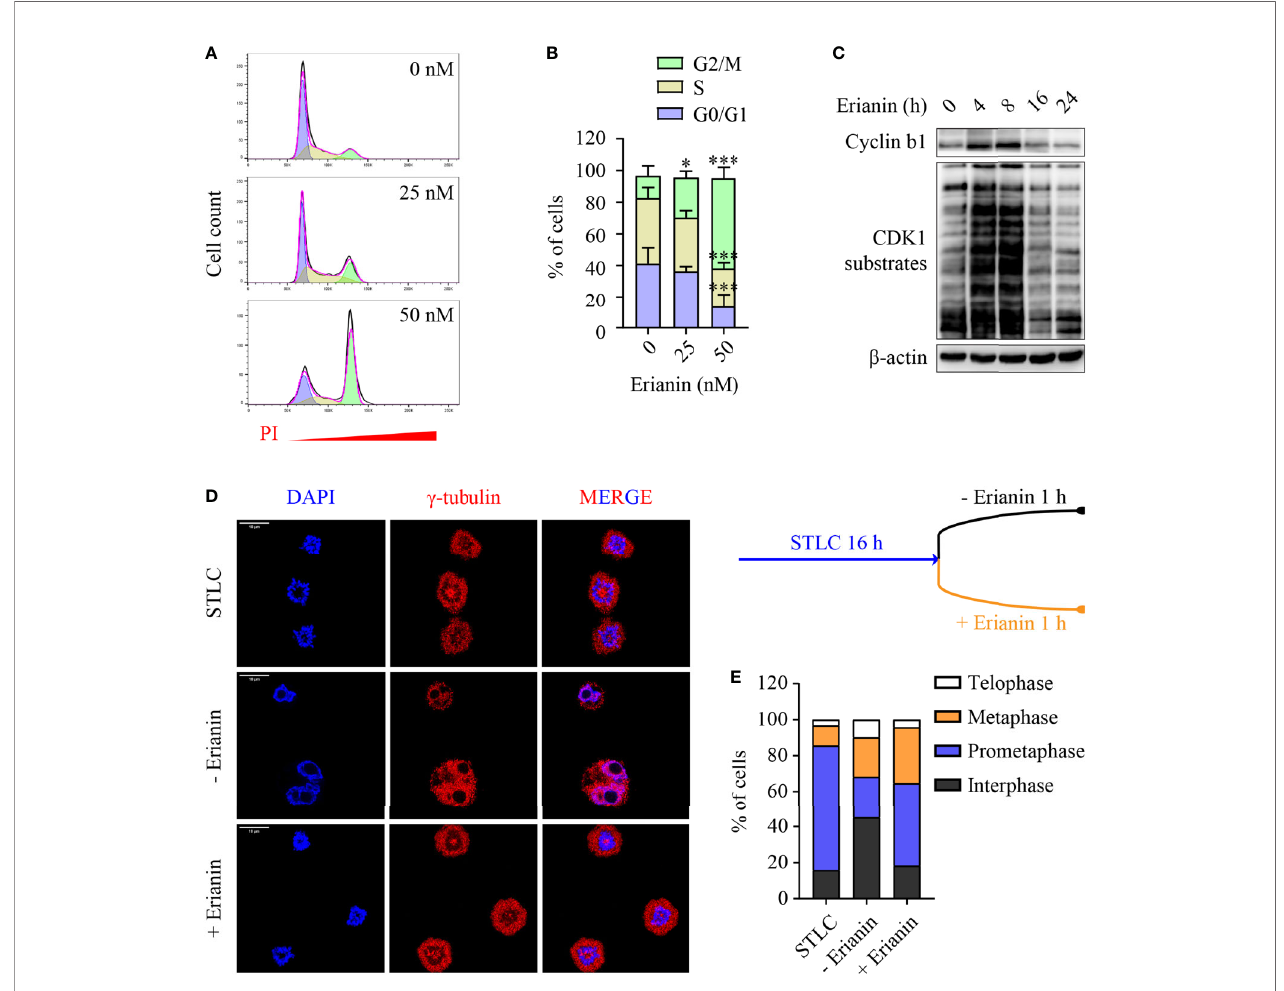
FIGURE 5 | Erianin induces cell cycle arrest at the M phase in PC3 cells. (A, B) PC3 cells were treated with erianin at indicated concentrations for 24 h. (A) Cell cycle phase was determined by fl ow cytometry with propidium iodide (PI) staining. G 0 /G 1 , S and G 2 /M phase populations were estimated using Flowjo software and are indicated in purple, yellow and green, respectively. (B) Percentages of cells at each phase was quanti fi ed by Flowjo software. Data are expressed as mean ± SD. n=5. * p < 0.05; *** p < 0.001, versus untreated control. (C) PC3 cells were treated with erianin at 50 nM for indicated times. Cyclin b1 and phosphorylated CDK1 substrates were examined by Western blotting. (D, E) Cells were treated with S-trityl-L-cysteine (STLC) at 10 µM for 16 h to synchronize cells at the prometaphase. Then STLC was withdrawn and cell cycle progression to metaphase, telophase and interphase were monitored in the presence ot absence of erianin at 100 nM for 1 h. Confocal images were captured. Bar = 10 µm (D) . Percentages of cells at each cell cycle phase were quanti fi ed (E)